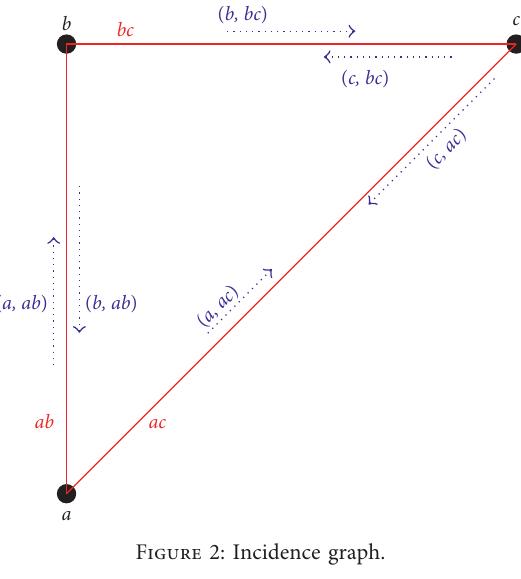
Figure 2: Incidence graph.